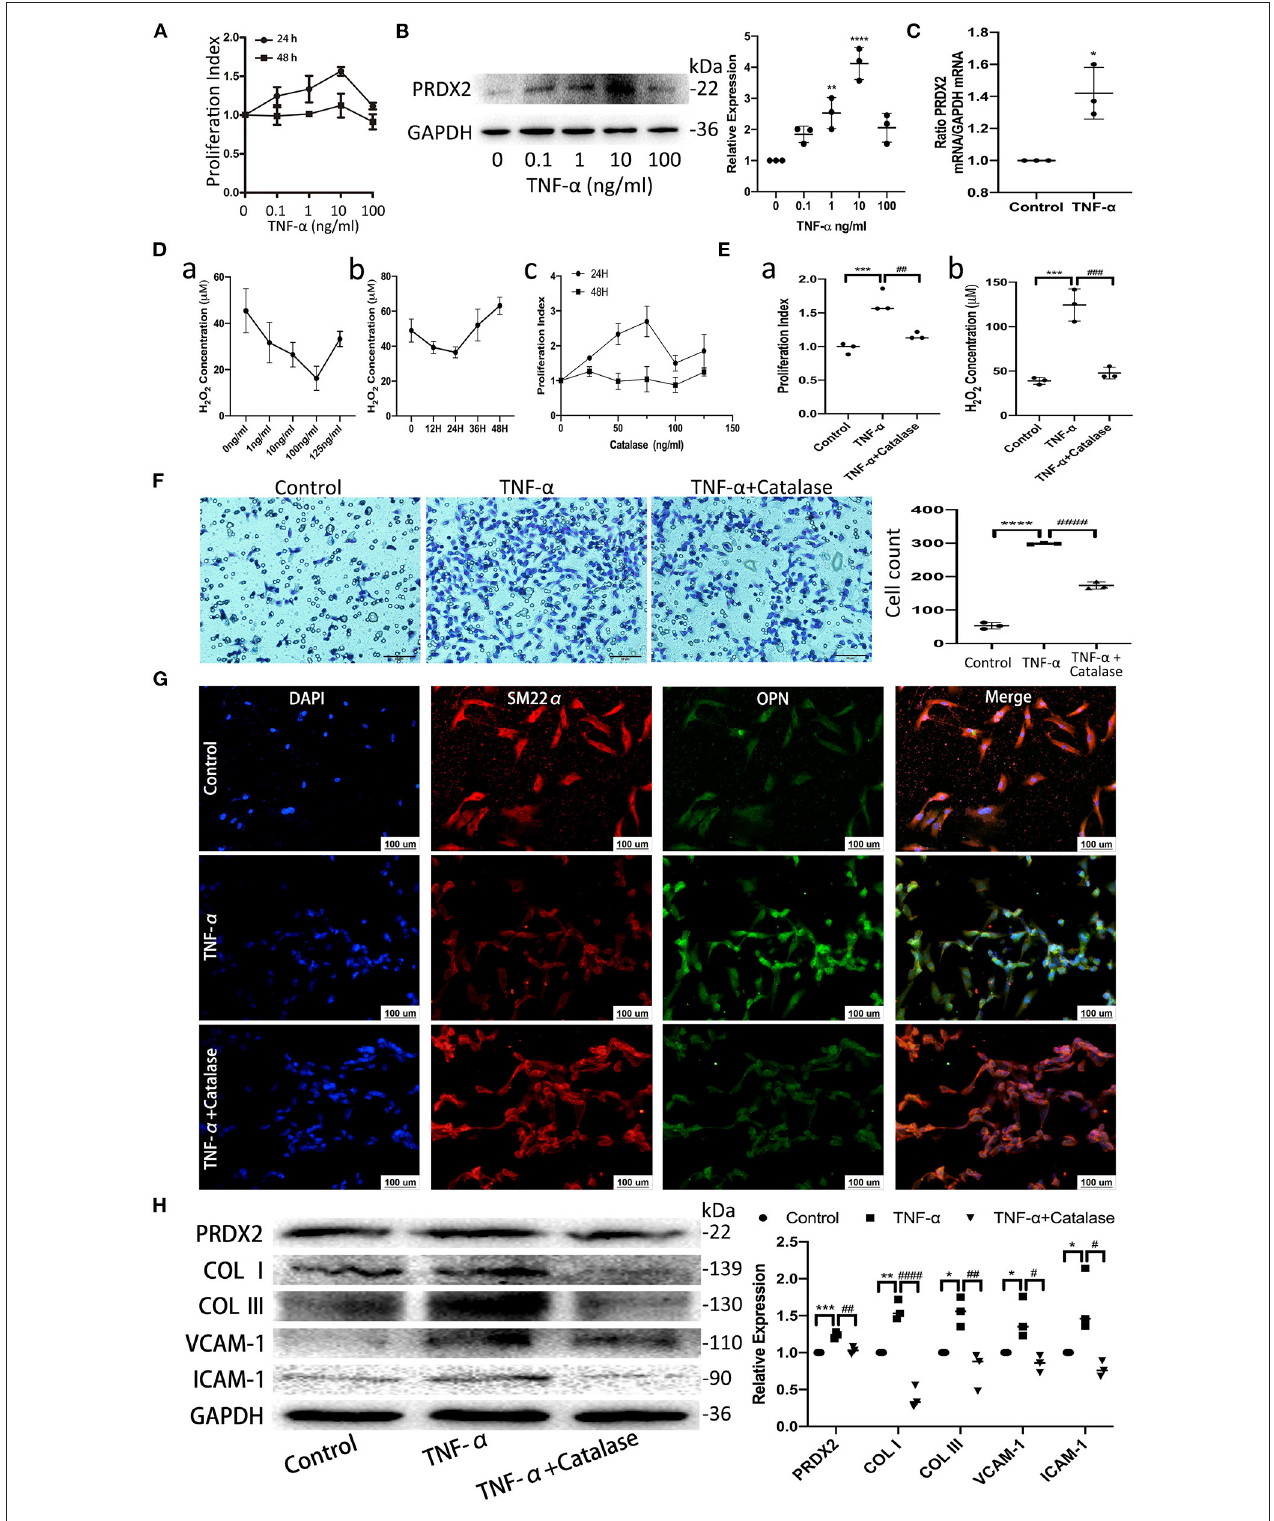
FIGURE 2 | PRDX2, as ROS scavenger, is involved in the process of TNF- α -induced CAVSMCs proliferation, migration, transformation, and collagens excessive accumulation. (A) Effects of different concentrations of TNF- α on the proliferation of the CAVSMCs. (B) PRDX2 protein expression in response to